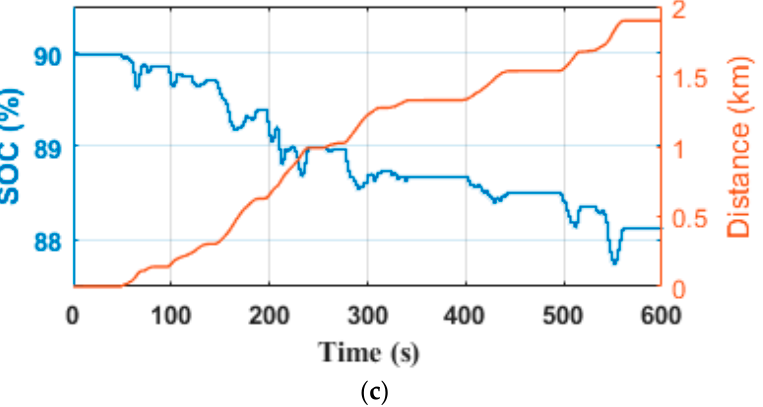
Figure 22. Li-ion battery performance with FDTC technique ( a ) voltage; ( b ) current; ( c ) state of charge, and covered distance.